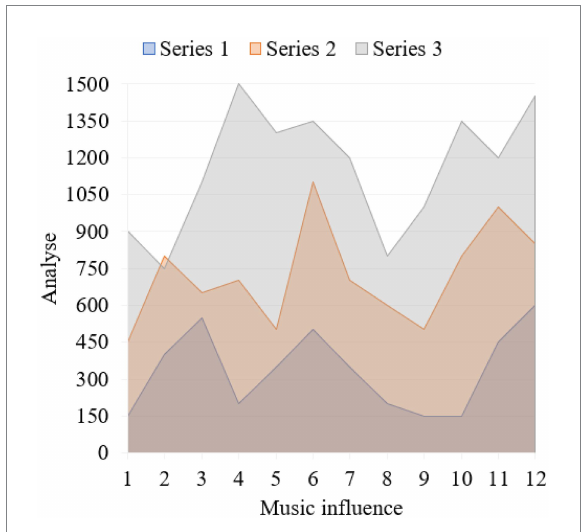
FIGURE 8 Data map of music education research and analysis.